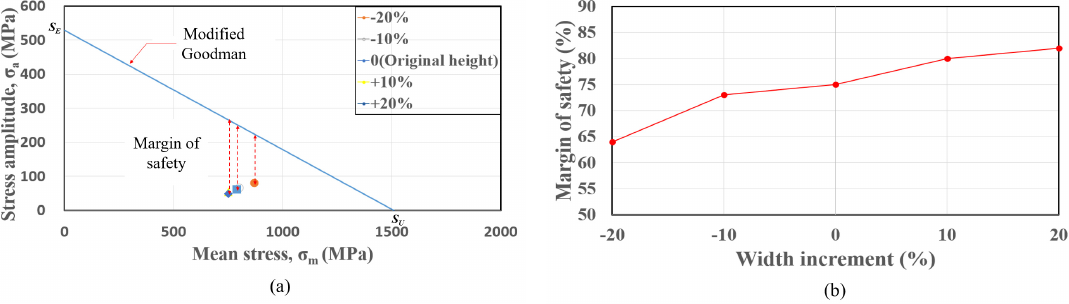
Figure 14. Comparison of the fatigue performances when varying the spring width: ( a ) fracture criteria; ( b ) safety margin (%).